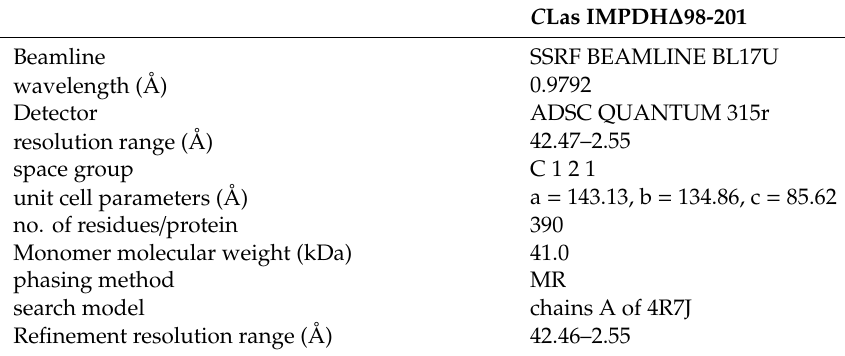
Table 1. Data collection and refinement